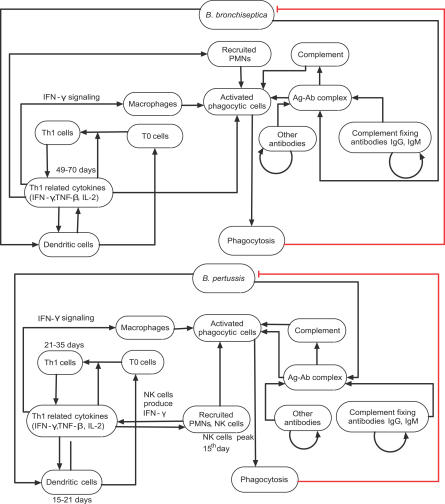
Phase III of In Silico PathogenesisDepicts Th1-related responses to the infection by B. bronchiseptica or B. pertussis.